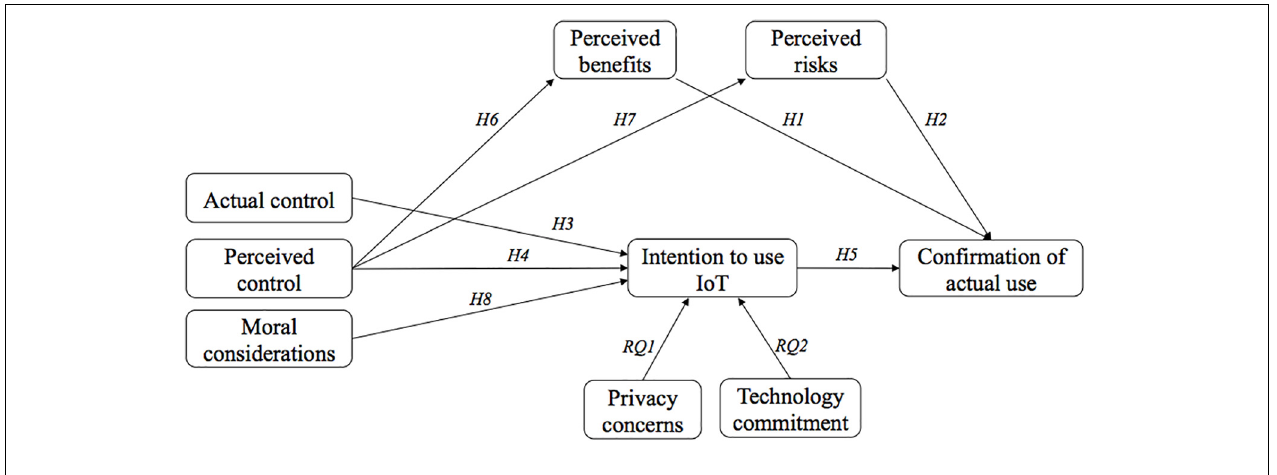
FIGURE 1 | Proposed research model.